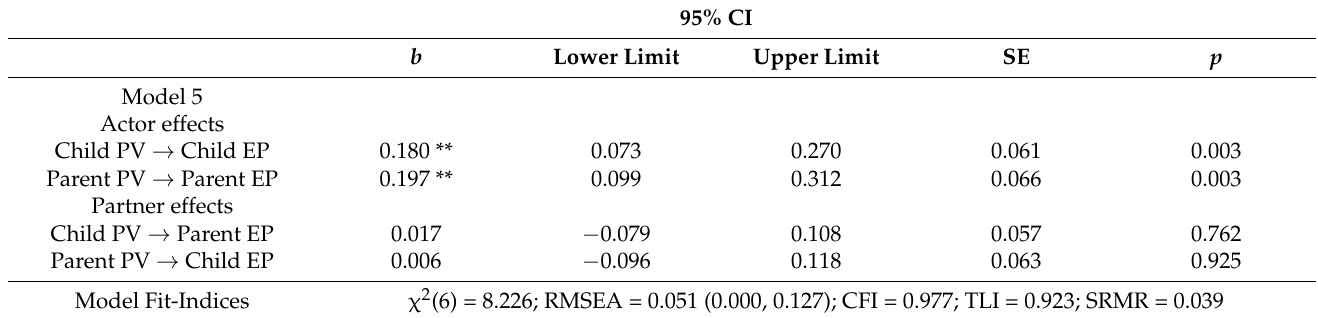
Table 6. Actor-partner interdependence models of child- and parent-reports of peer bullying and child outcomes ( n =